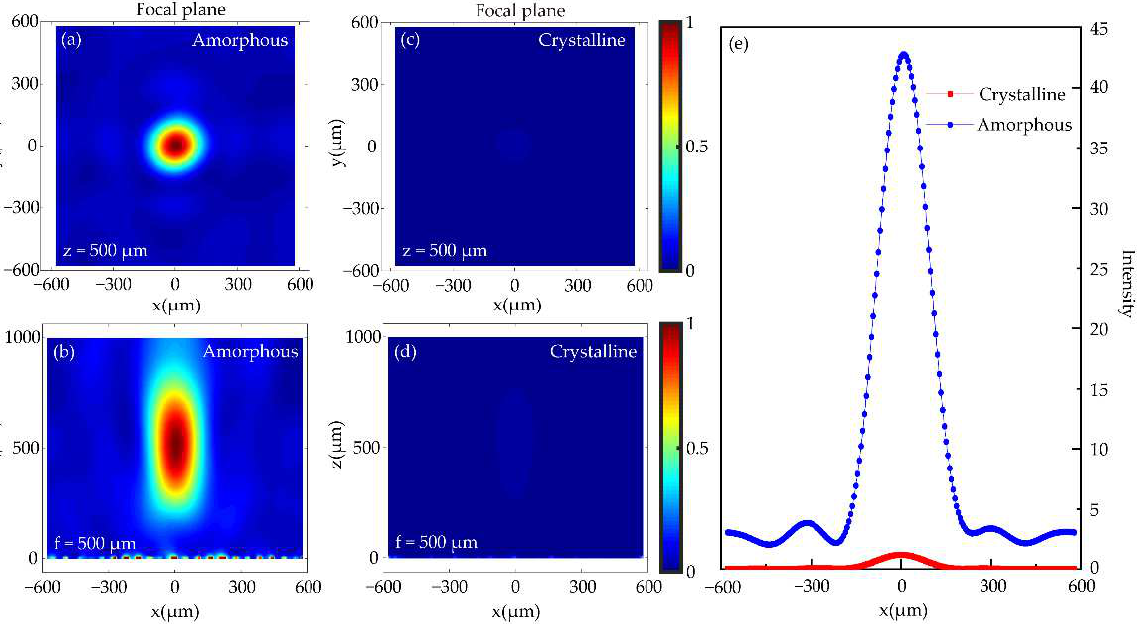
Figure 9. The focus situation of four reflective focusing metalenses at four frequencies in different GST states. 4. Conclusions In this paper, the tunable wavefront manipulation of terahertz electromagnetic wave is realized via the combination of plasmonic metasurface with phase change material GST. The optimization of enabling wavefront manipulation in one state and suppressing it in another state is sophisticated and require elaborate design to make a balance between the